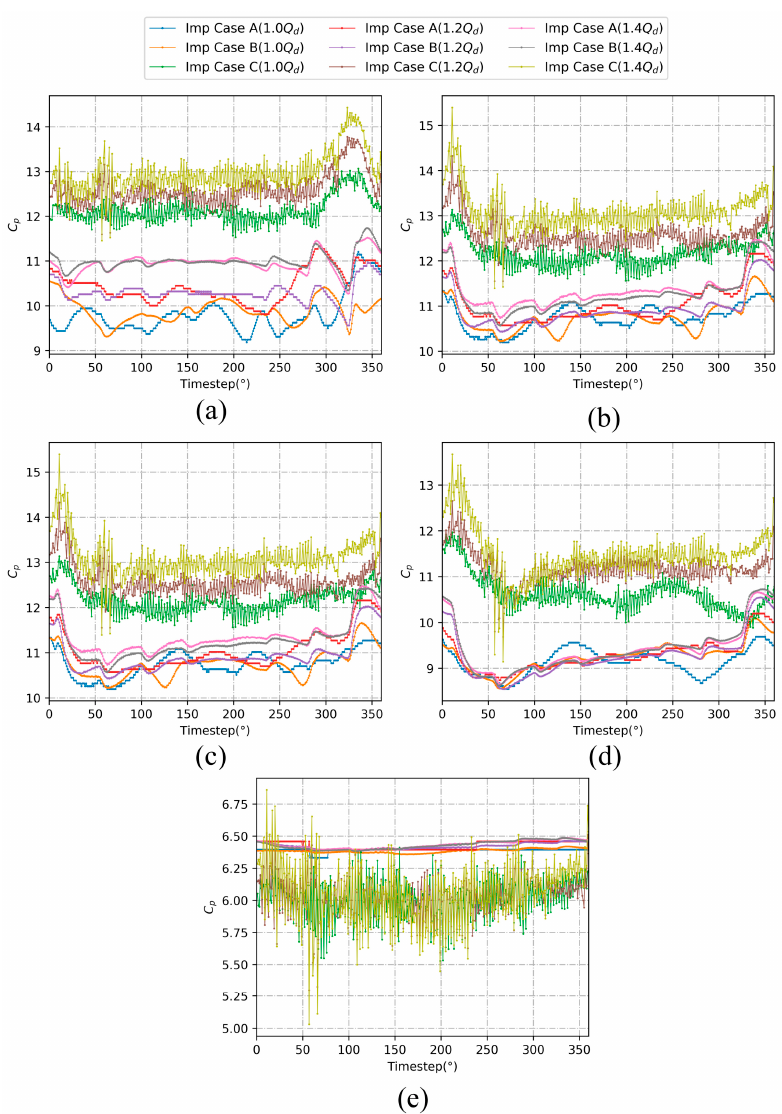
Figure 17. Time-domain of pressure fluctuations at different monitoring points within the impeller of the three optimized impeller cases at the locations of: ( a ) Imp1, ( b ) Imp2, ( c ) Imp3, ( d ) Imp4 and ( e ) Imp5.